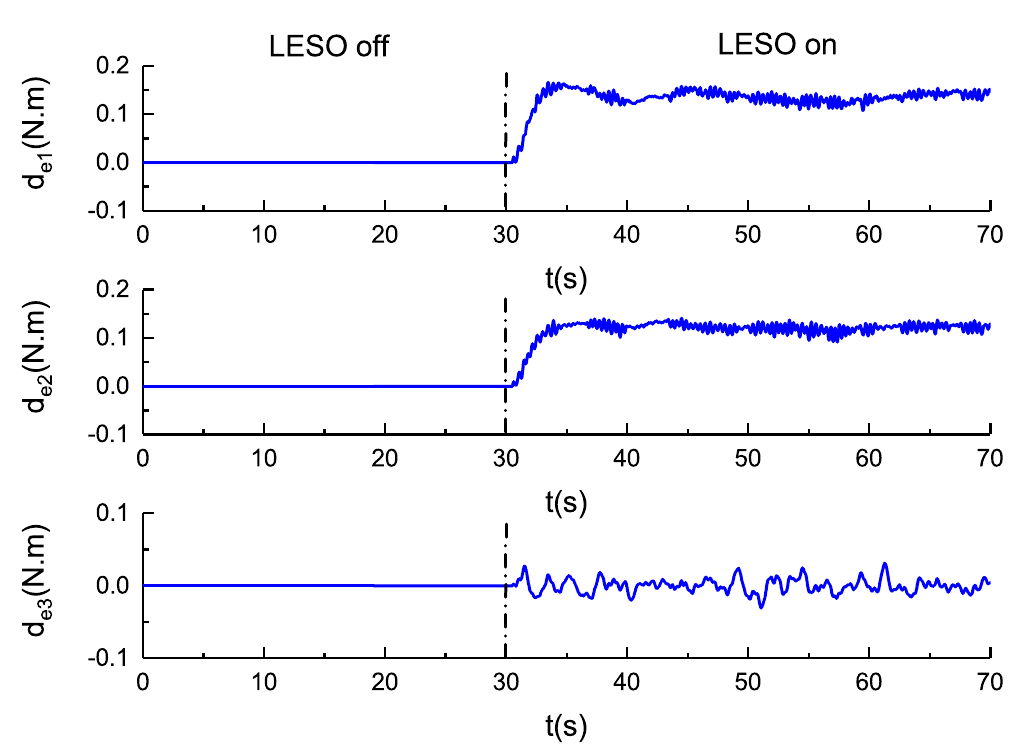
Figure 7. Disturbance estimation with the LESO on using attitude